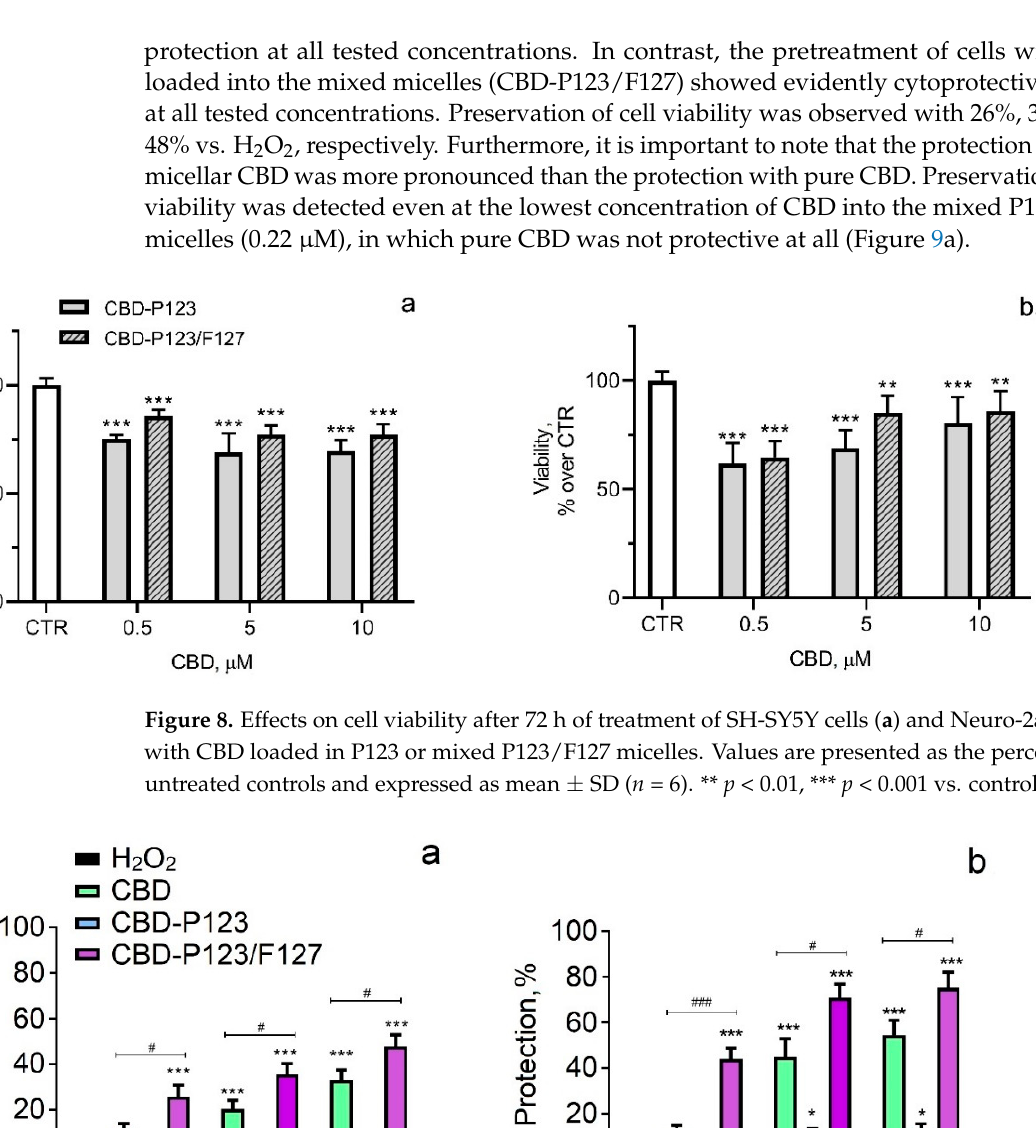
Figure 7. Comparative evaluation of the diameter of SH-SY5Y ( a ) and Neuro-2a ( b ) cells by for-